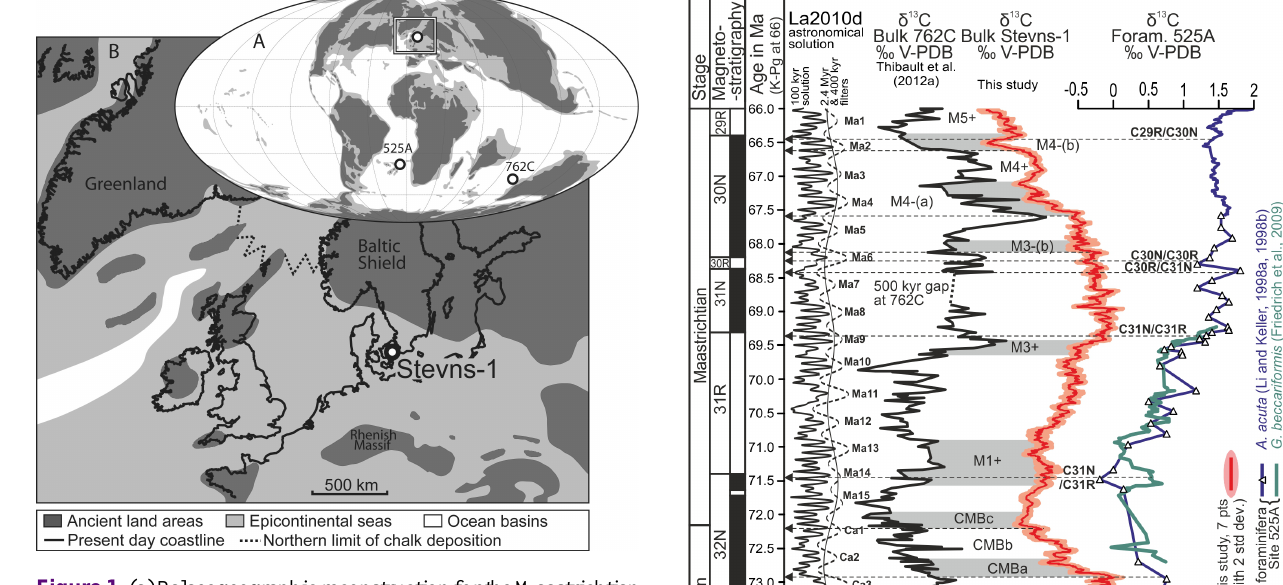
Figure 1. (a) Palaeogeographic reconstruction for the Maastrichtian (66Ma) showing location of the Boreal Chalk Sea (square) and key localities discussed in the text (after Markwick and Valdes, 2004, modified). (b) Palaeogeographic reconstruction of the Boreal Chalk Sea for the Maastrichtian with location of Stevns-1 (after Surlyk et al., 2003, modified).